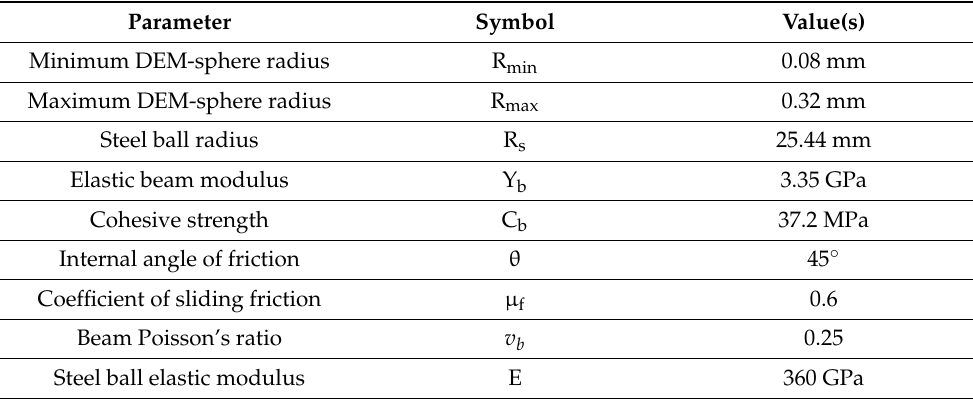
Table 1. Model parameters used to configure the DEM environment for simulated impact breakage of a SILC.